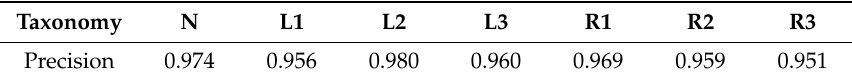
Table 5. Precision of IDFNP for Every Taxonomy.